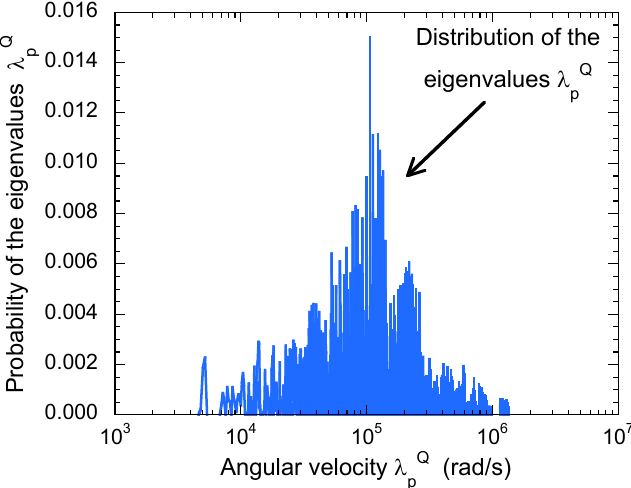
Figure 12. Histograms of the distribution of the angular velocities λ Q p corresponding to the quadrupolar relaxation mechanism that may be probed by the spin-locking experiments of I = 7/2 spin for irradiation powers ω 1 varying between 2.7 × 10 3 and 2.1 × 10 5 rad · s − 1 ( 133 Cs NMR). Reprinted with